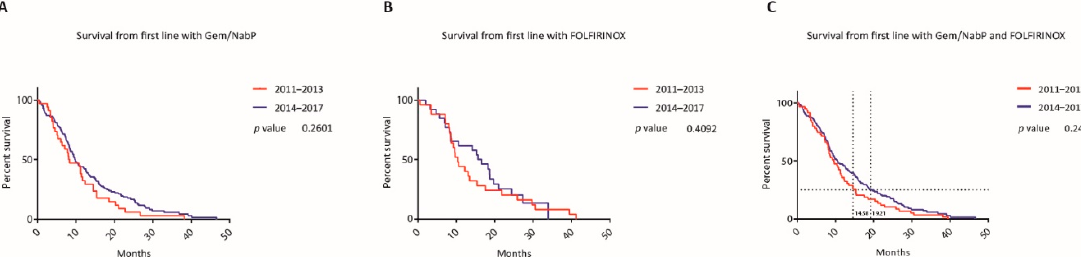
Figure 4. Survival between most popular first line regimens between the two time periods. Kaplan-Meier curves of patients who started a first line therapy with gemcitabine/nab-paclitaxel ( A ), mFOLFIRINOX ( B ) or with either one of these regimens ( C ) according to the year when the first systemic treatment was administered. Horizontal grid lines indicate the survival proportion of 25% and intersections with vertical grid lines indicate the survival time for the respective Kaplan-Meier curves at this point.